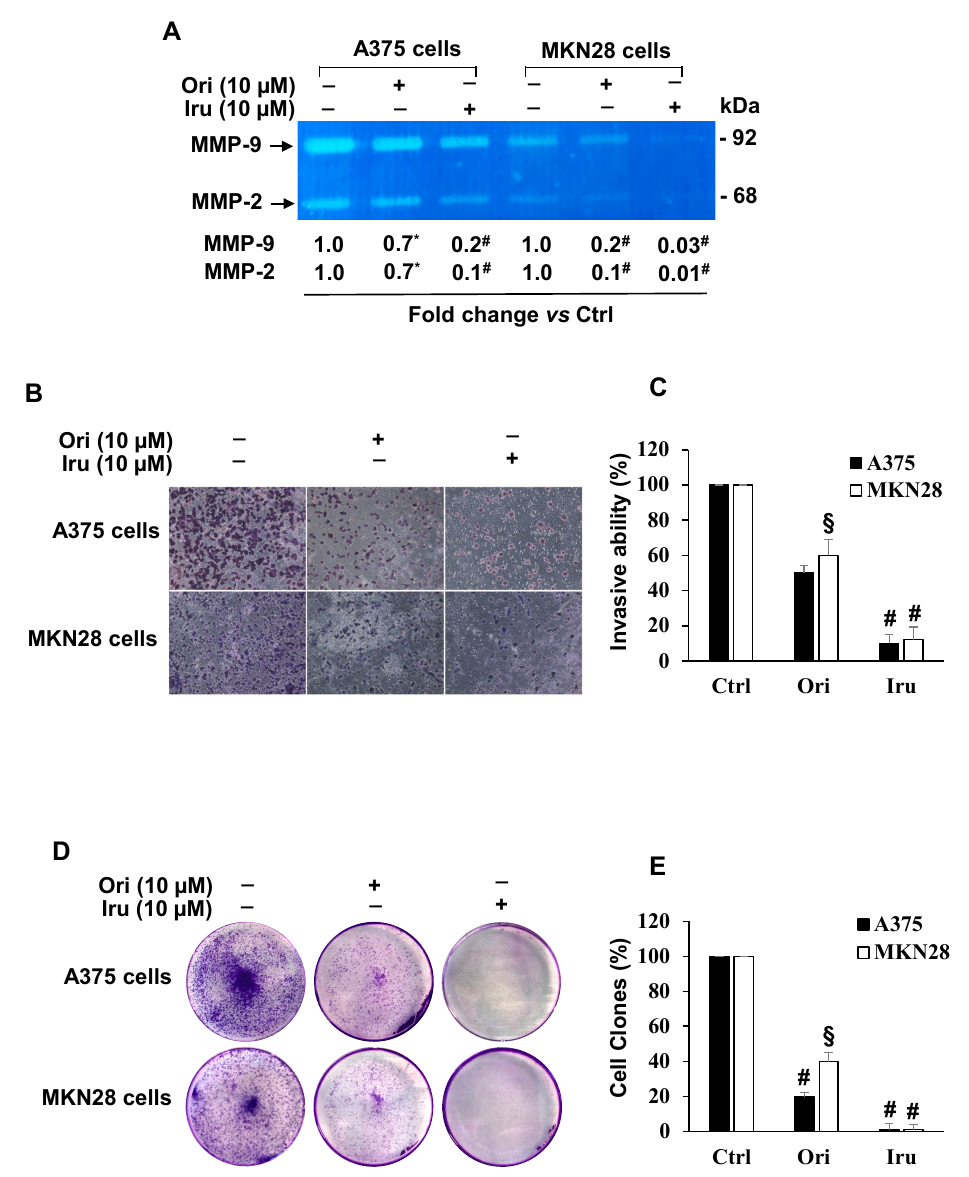
Figure 6. E ff ect of Ori and Iru exposure on A375 and MKN-28 cell invasion, MMP-9 and MMP-2 activity and colony formation. ( A ) Gelatin zymography of MMP-9 and MMP-2 in A375 and MKN-28 cells. Fold change in MMP-9 and MMP-2 activity was calculated by first normalizing with Ponceau-S staining of membranes (Control of protein loading) in individual samples and then relative to untreated control (cells cultured DMEM with 0.1% DMSO, vehicle) set as 1. The numbers with (*, #) were statistically di ff erent from control (* p < 0.05; # p < 0.001). Statistical analysis of the results obtained in triplicate experiments are reported in the Figure S1. ( B ) Representative phase-contrast-photomicrographs (10 × objective) of random fields of matrigel invasion assay in A375 and MKN28 cells. ( C ) The invasive capability was determined by cell counting in five fields, randomly selected, per membrane. Quantification was relative to untreated cells, cultured in DMEM with 0.1% DMSO, vehicle, set as 100%. Results are presented as mean ± SD ( n = 9). Columns with (*, §, #) were statistically di ff erent from untreated control cells (* p < 0.05, § p < 0.01, # p < 0.001). ( D ) Representative images of clonogenic analysis in A375 and MKN28 cells. ( E ) The colony number quantification was relative to untreated cells, cultured in DMEM with 0.1% DMSO, vehicle, set as 100%. Results are presented as mean ± SD ( n = 9). Columns with (§, #) were statistically di ff erent from untreated control cells (§ p < 0.01, # p <